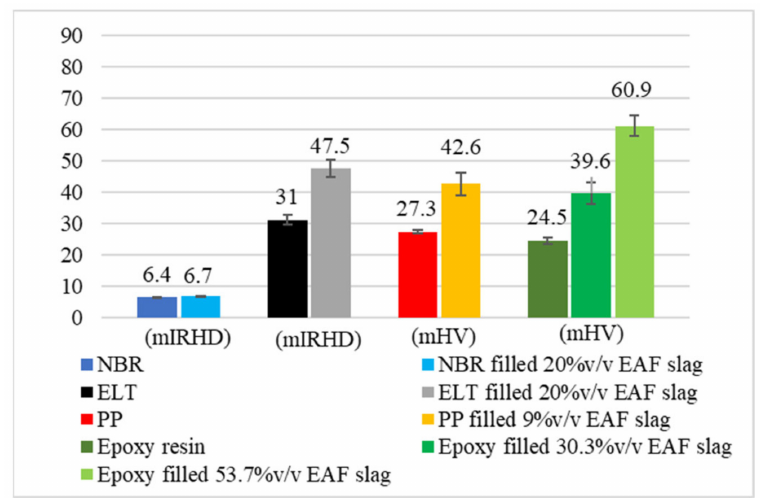
Figure 7. Influence of EAF slag as filler for NBR, ELT, PP, and epoxy resin matrix on hardness mIRHD or mHV in function of polymer